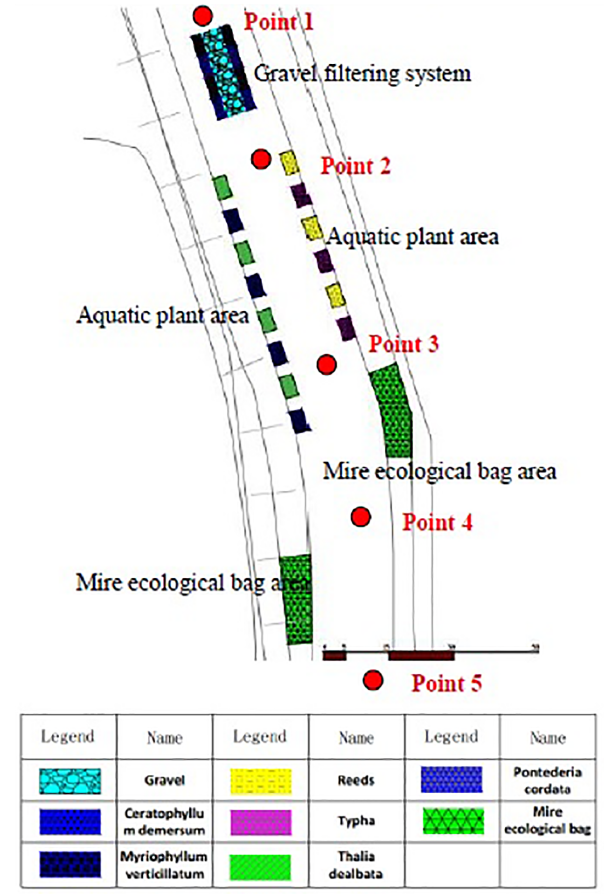
Figure 2. Filtering system